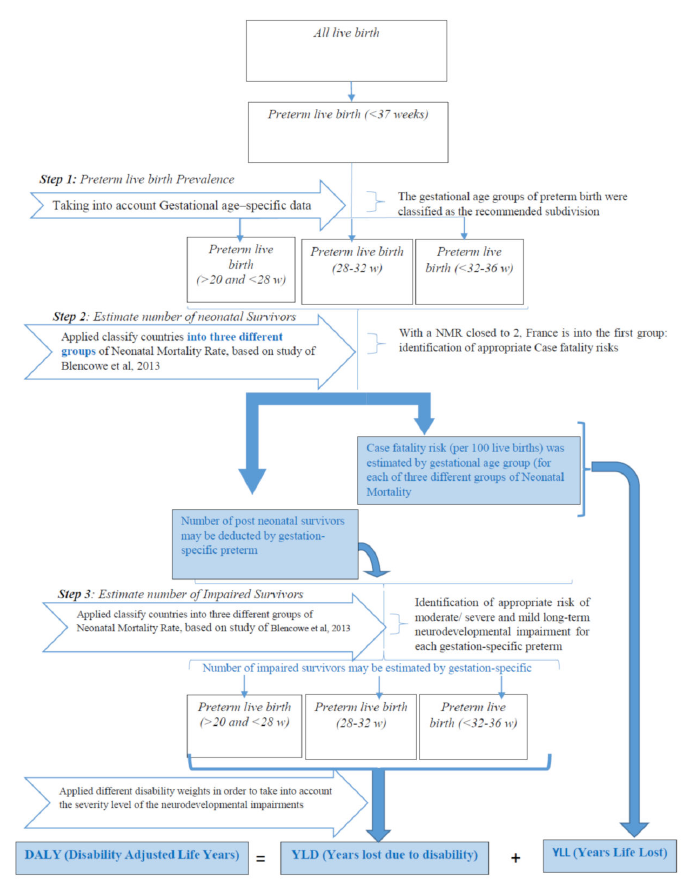
Figure 1. Descriptive of DALYs (disability adjusted life years)